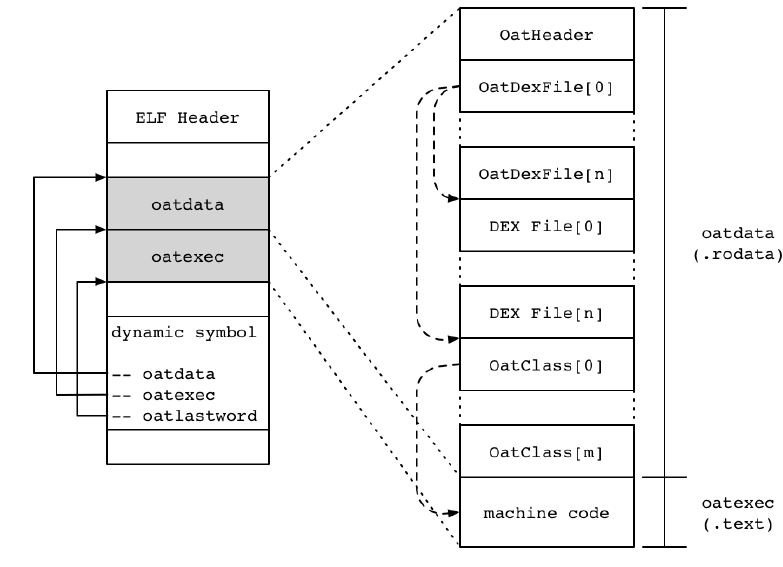
Figure 1. OAT file structure.